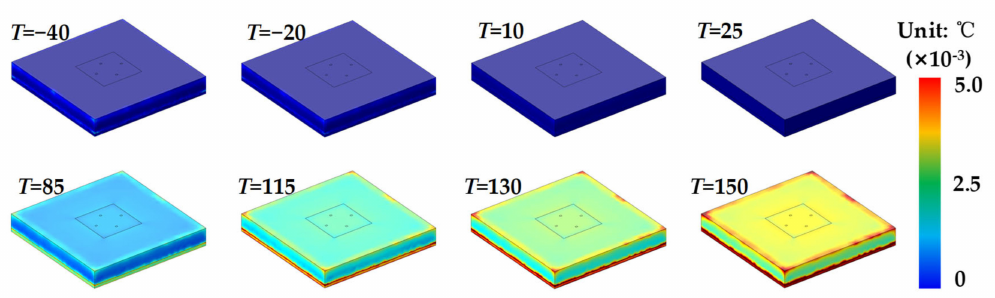
Figure 8. Surface strain of the MEMS pressure chip at different